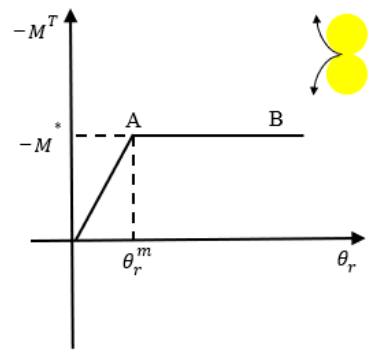
Figure 2. Schematic diagram of the anti-rolling linear contact model: ( a ) Normal contact part, ( b ) Tangential contact part, ( c ) Anti-rolling contact part. (Adapted with permission from Ref. [33]. 2014, Song, Y.; Yang, L.; Zhao, J).